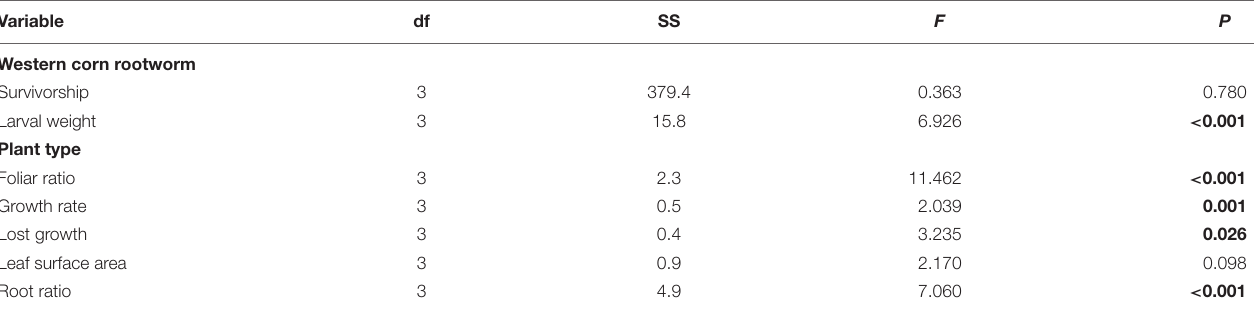
TABLE 1 | Analysis of variance (ANOVA) statistics for the independent variables ‘plant type’ (Balsas teosintes, Mexican maize landraces, US maize landraces, and US inbred maize lines) and seven plant and Western corn rootworm dependent variables associated with plant resistance. Variable df SS F P